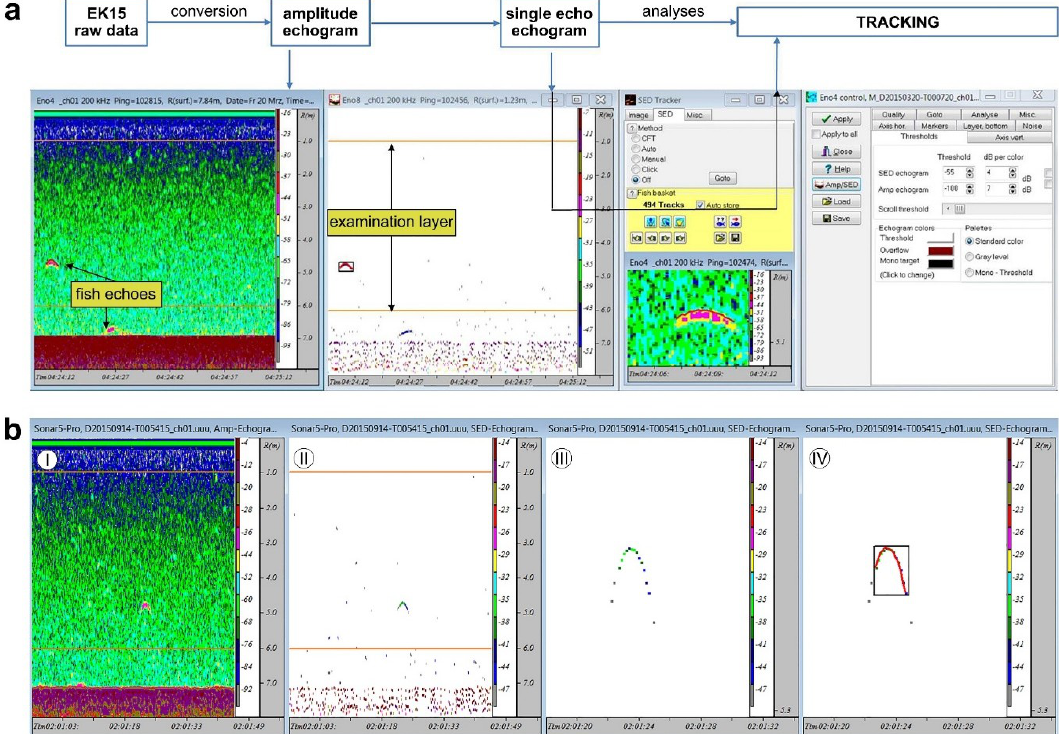
Figure 3. EK15 echosounder post‐processing workflow. ( a ) The raw data files are converted to amplitude echograms (AMP) and single echo detection echograms (SED). The selected region (examination layer) is analyzed using an automated tracking algorithm. ( b ) The fish tracking process: (I) Fish target determination in the AMP‐echogram. (II) Identification of the same fish target in the SED echogram. (III) Single echoes of the fish target over time. (IV) The completed track by with connecting single echo location. Note that three single echoes were not included in the track, as they did not match the tracking criteria and were not considered.